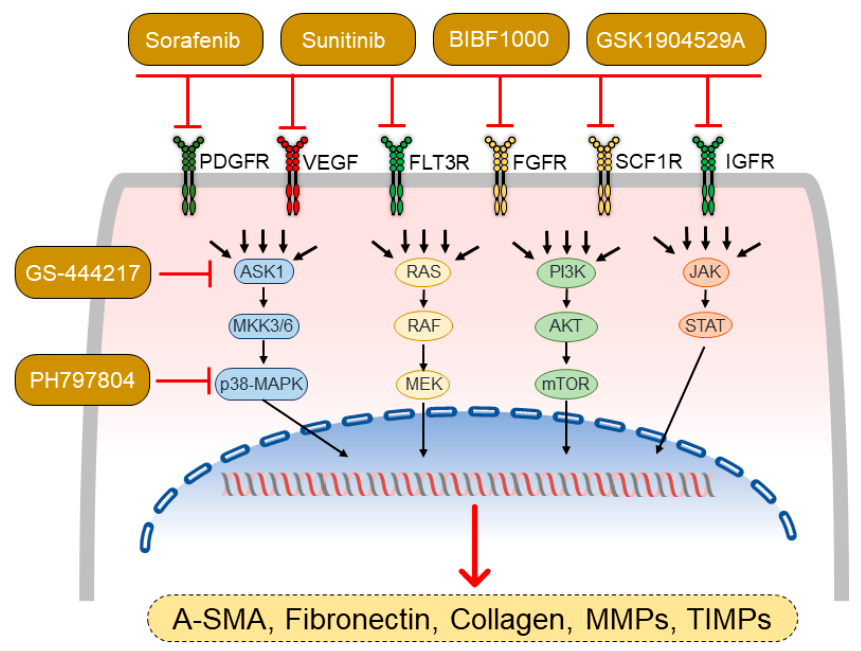
Figure 3. Mechanisms of agents identified to attenuate myocardial fibrosis in pulmonary artery banding (PAB)-induced right ventricular (RV) remodeling. BIBF1000, a nintedanib analogue that targets VEGFRs, PDGFRs, and FGFRs, GSK1904529A, a specific IGF-1R inhibitor, sorafenib, a multi- kinase inhibitor of PDGFRs, VEGFRs, Flt3, c-Kit, c-RAF, and b-RAF, and sunitinib, an inhibitor of PDGFRs, VEGFRs, Flt3, KIT, CSF1R, and RET have been shown to attenuate myocardial fibrosis by inhibiting the activity of cardiac fibroblasts and attenuating the expression of profibrotic genes such as α -SMA (actin alpha 2), fibronectin, collagen, MMPs (matrix metalloproteinases), and TIMPs (tissue inhibitors of metalloproteinases), thus improving RV function in animal models of